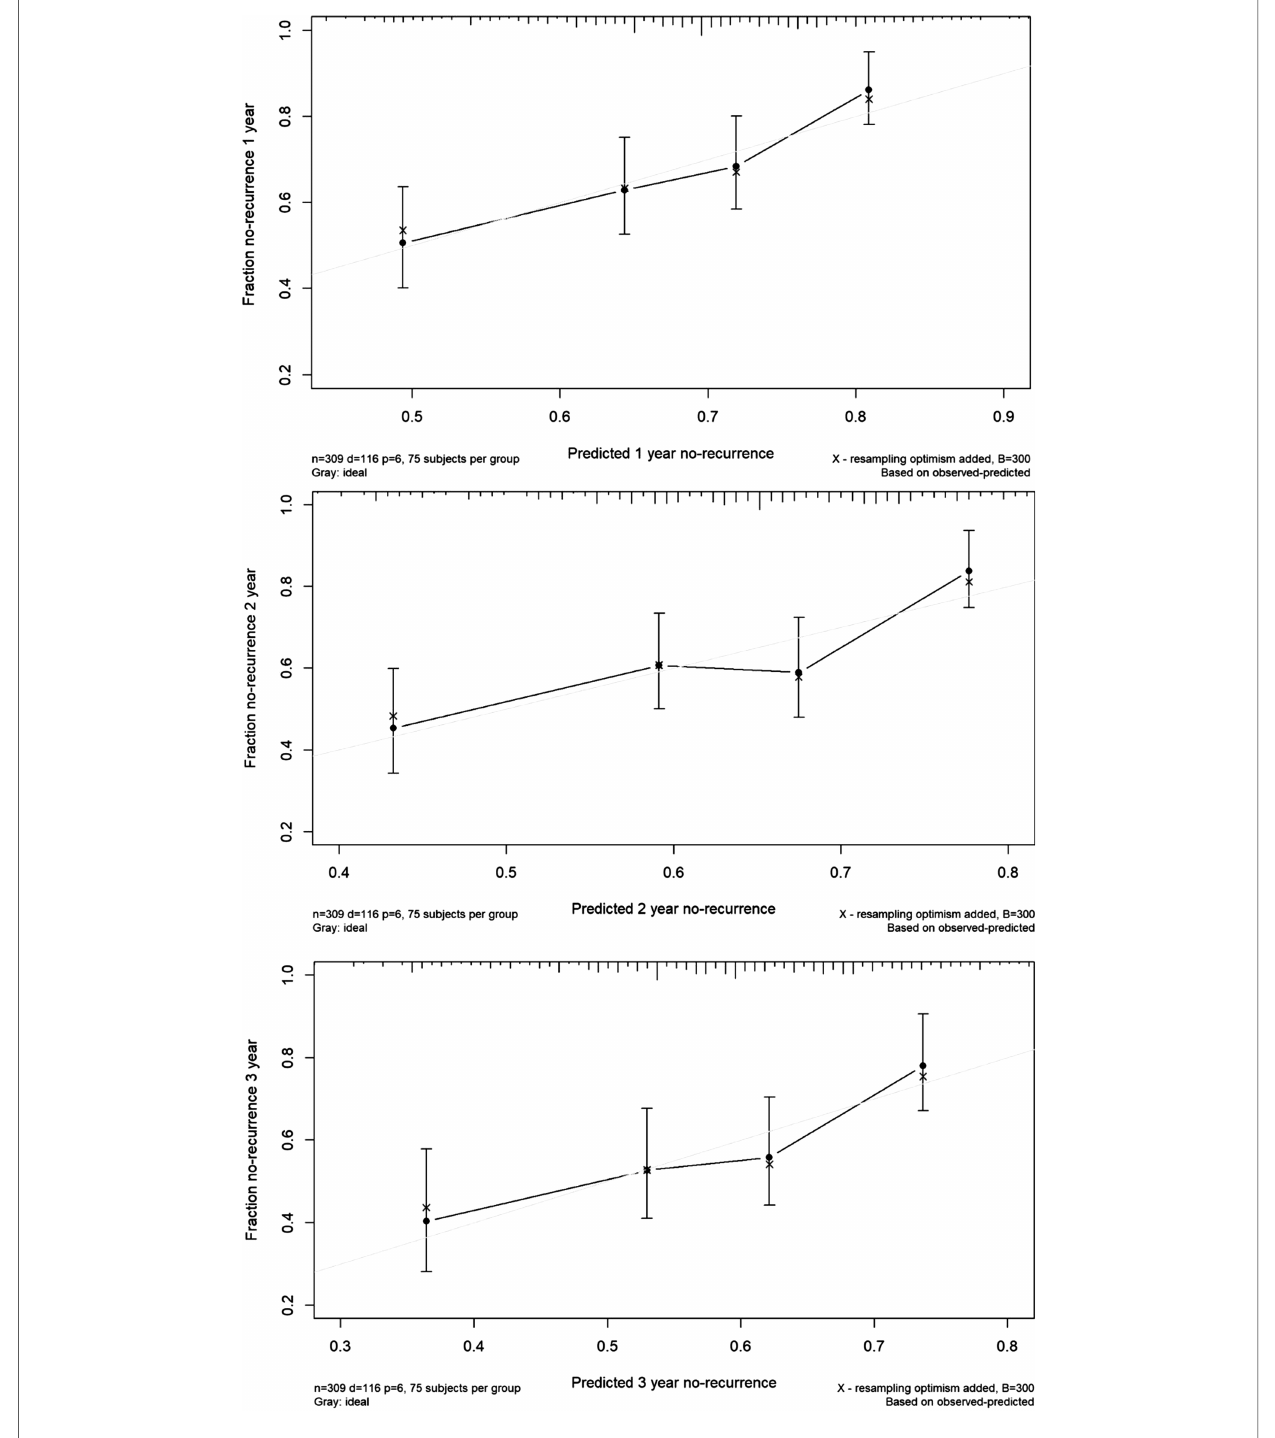
FIGURE 3 The calibration curves for predicting the risk of no-recurrence of vasovagal syncope at 1-year (the upper panel), 2-year (the middle panel) and 3-year (the lower panel) among all study children. Nomogram-predicted probability of no-recurrence is plotted on the X-axis, and actual no-recurrence is plotted on the